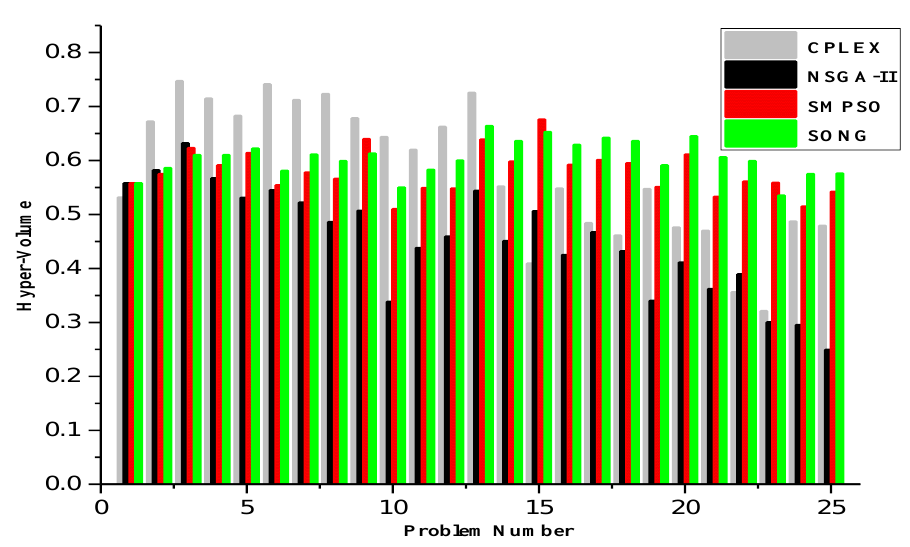
Figure 15. Comparison of HV